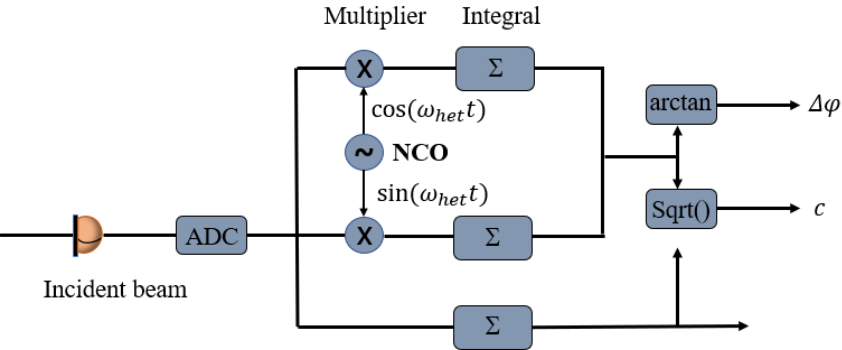
Figure 3. Schematic diagram of the quadrature demodulation algorithm. The incident light is converted into an electrical signal by the phase meter, the NCO emits a signal with a heterodyne frequency and the interference signal is multiplied and integrated to obtain a phase signal.